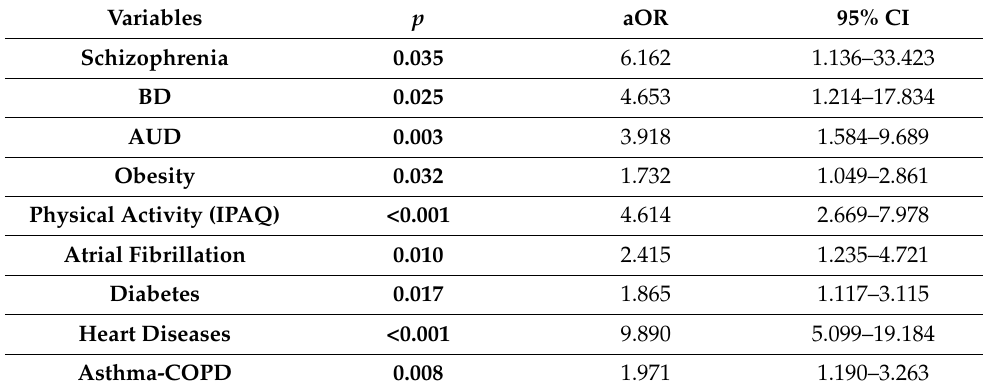
Table 3. Adjusted odds ratios with their 95% confidence intervals from the logistic regression of ischemic stroke among cases and control. Logistic Regression Taking the Presence vs. Absence of Ischemic Stroke as the Dependent Variable and Taking AUD, BD, and Schizophrenia as Independent